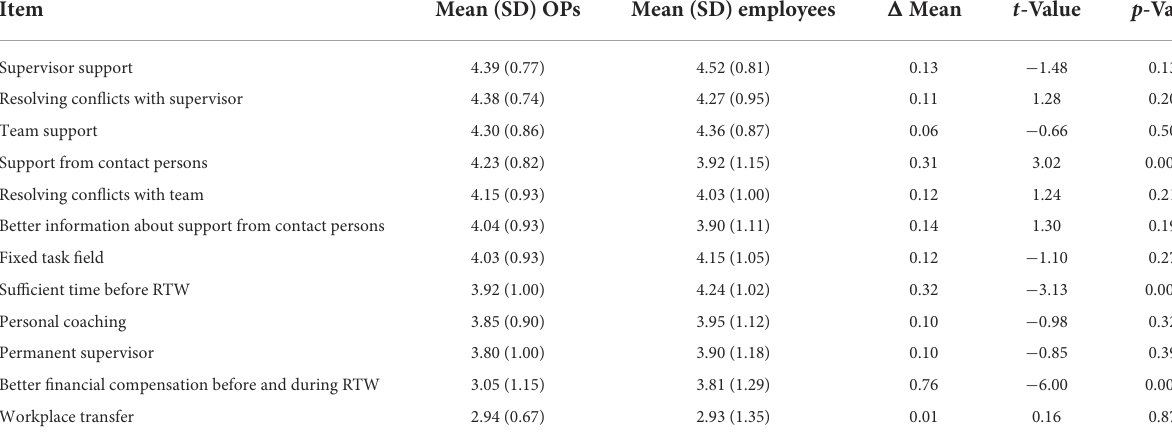
TABLE 3 Relevance of interventions fostering sustainable RTW assessed by OPs and